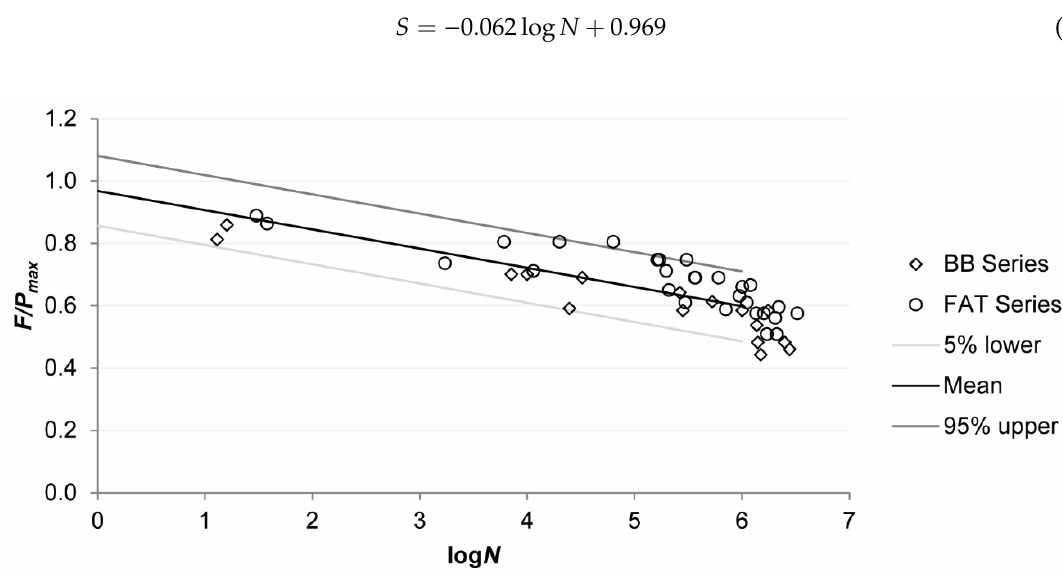
Figure 6. Relation between the number of cycles N and the applied load ratio F / P max in all the fatigue experiments, adapted from Reference [37]. Reprinted with permission. This figure was originally published in Vol. 116 of the ACI Structural Journal.